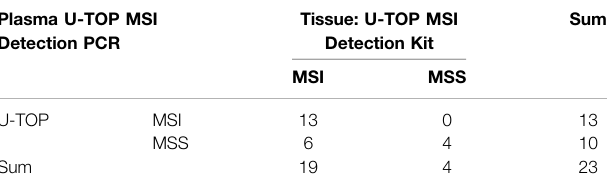
TABLE 3 | Concordance rate between plasma U-TOP MSI Detection PCR and tissue U-TOP MSI Detection PCR. Plasma U-TOP MSI Detection PCR